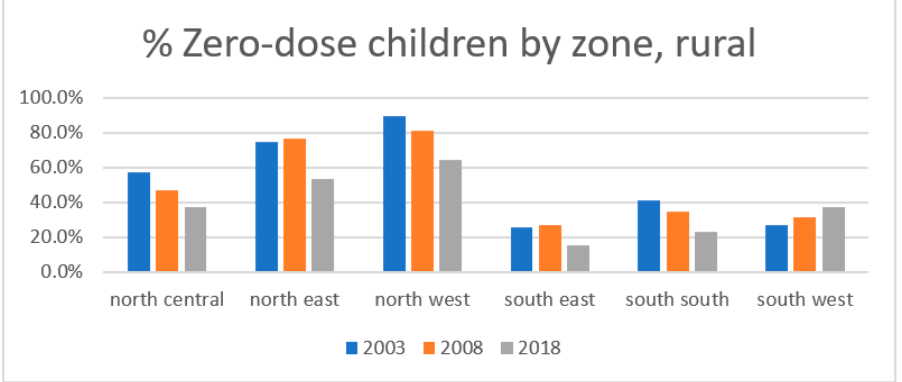
Panel C: Prevalence of zero-dose children by zone, rural areas. Figure 1. Prevalence of zero-dose children over time. Figure 1. Prevalence of zero-dose children over